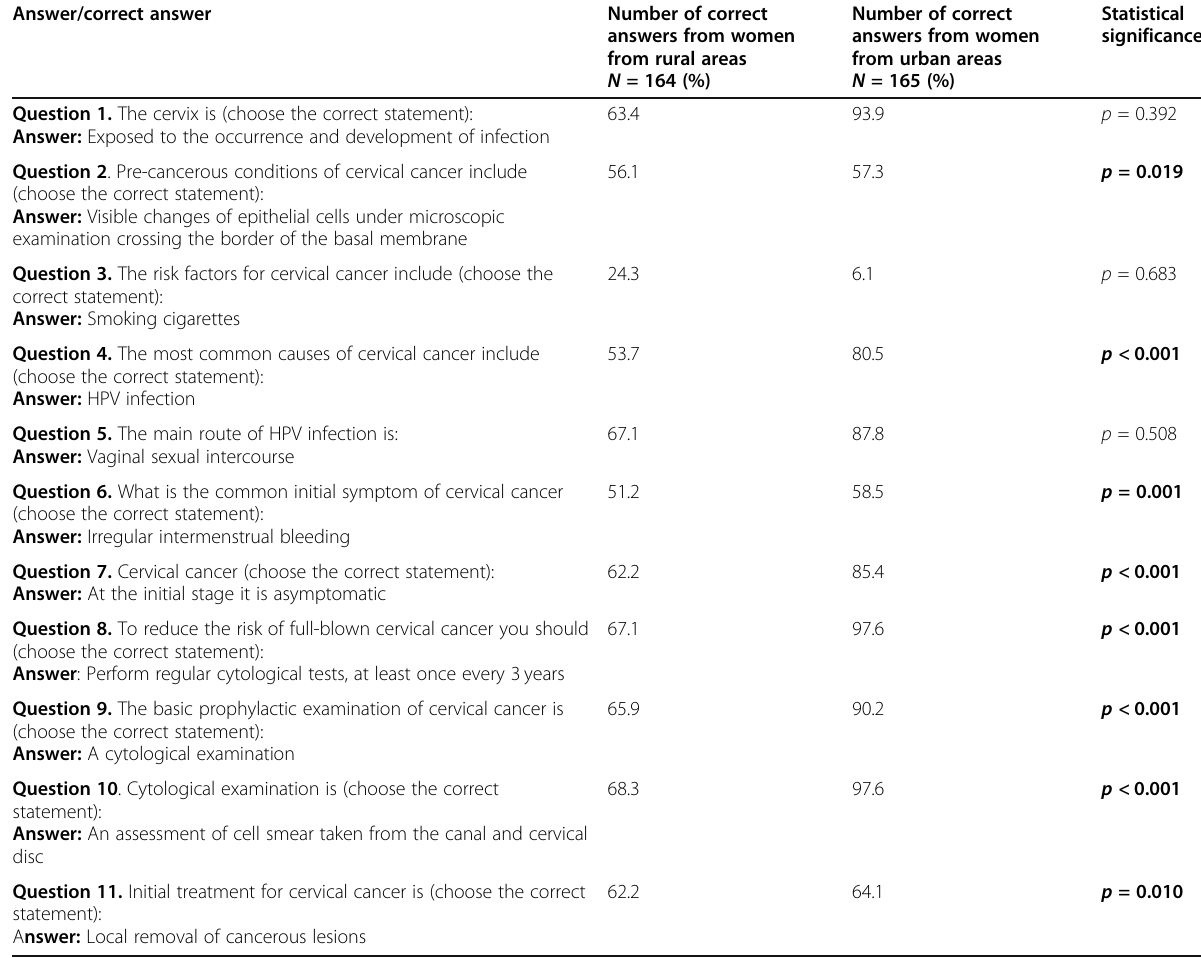
Table 2 Summary of questions and percentage of correct answers from the questionnaire with the number of respondents and the breakdown by village and city